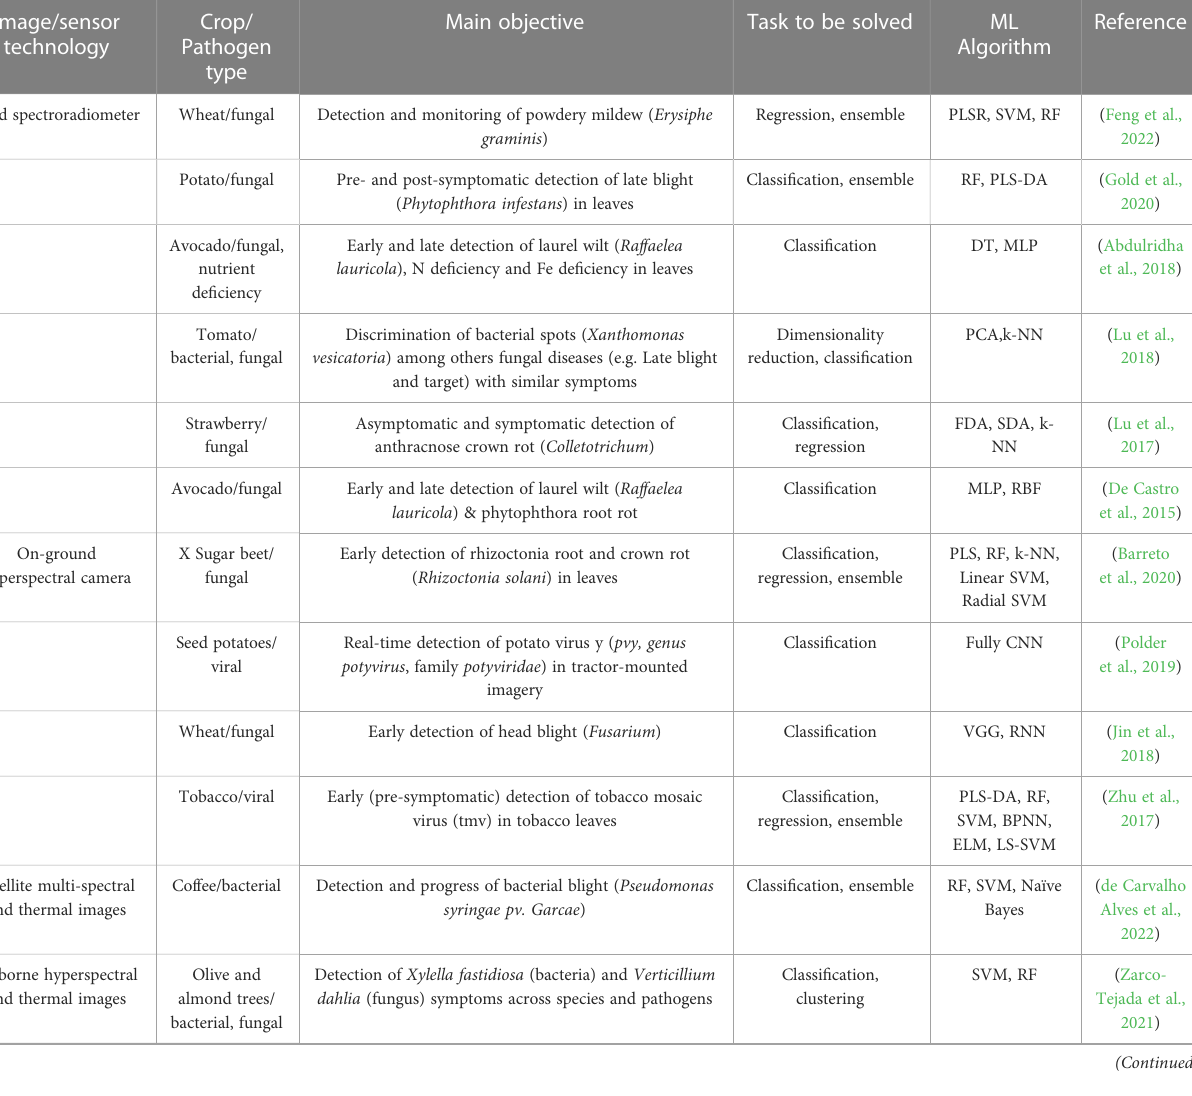
TABLE 3 Relevant investigations on ML algorithms in the domain of crop